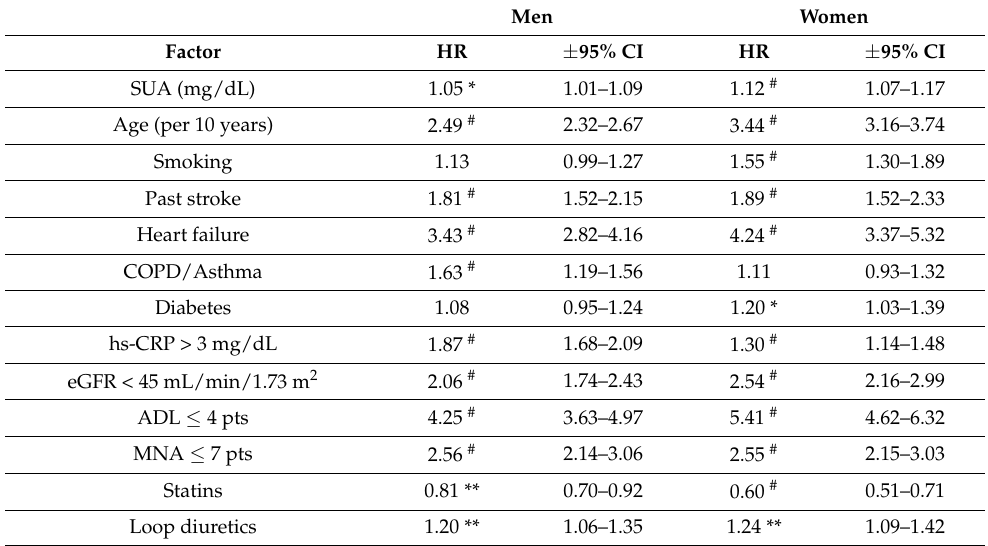
Table 2. Factors affecting the overall survival. Results of the univariate logistic regression analysis.